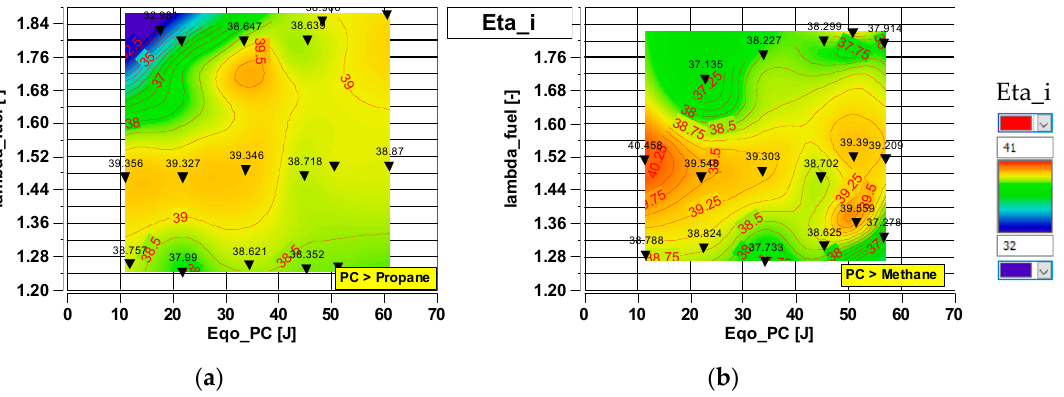
Figure 15. Indicated engine efficiency maps related to the energy contained in the fuel dose to the prechamber: ( a ) propane; ( b ) methane.